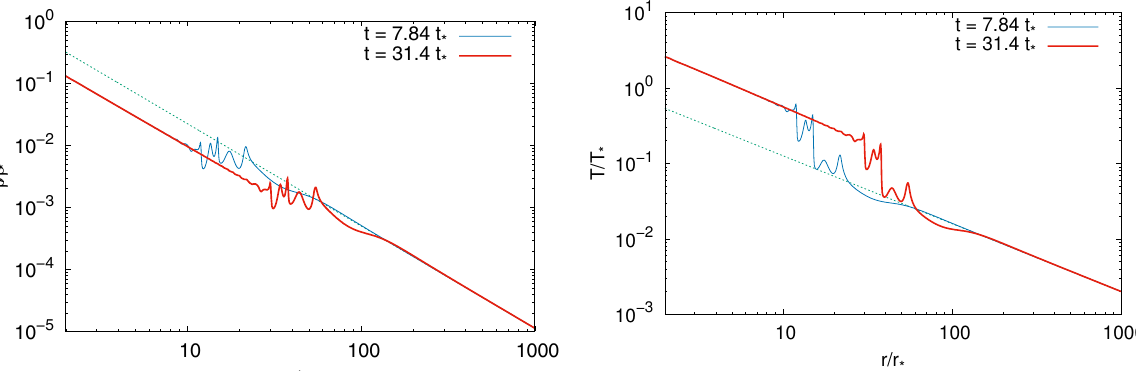
Figure 1. Radial density distribution ρρρ (left) and temperature TTT (right) at two time moments t = 7 . 84 t ∗ t = 7 . 84 t ∗ t = 7 . 84 t ∗ and t = 31 . 4 t ∗ t = 31 . 4 t ∗ t = 31 . 4 t ∗ . Initial distributions are shown as a dotted